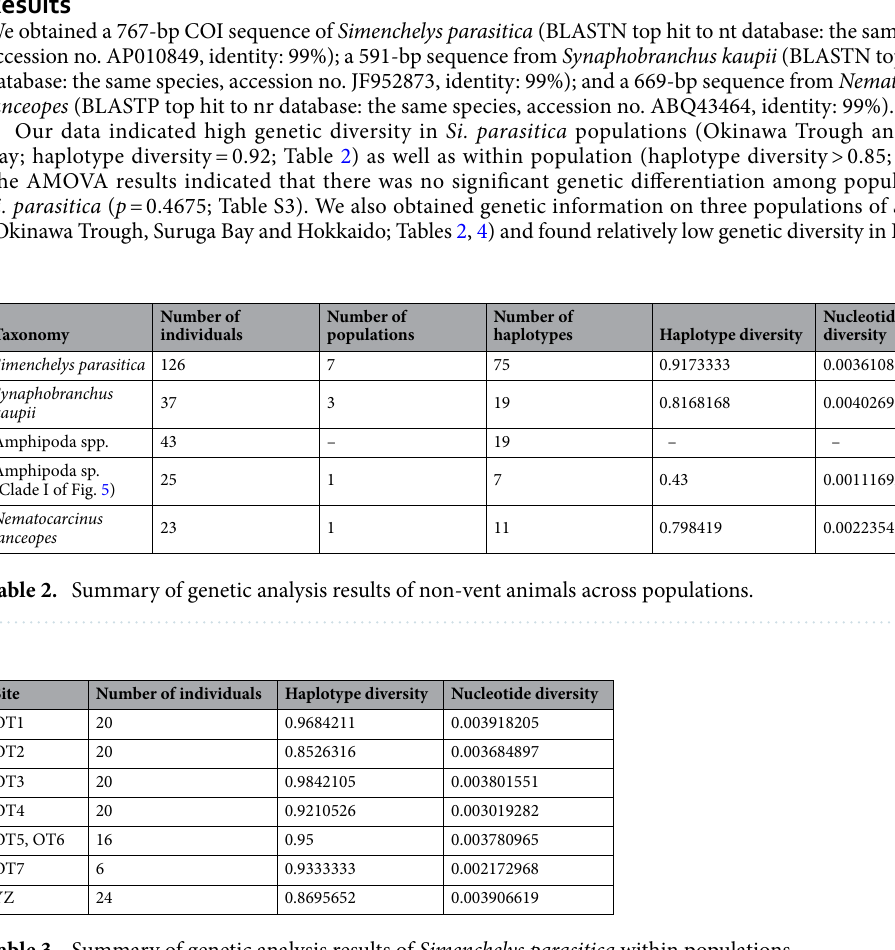
Table 3. Summary of genetic analysis results of Simenchelys parasitica within